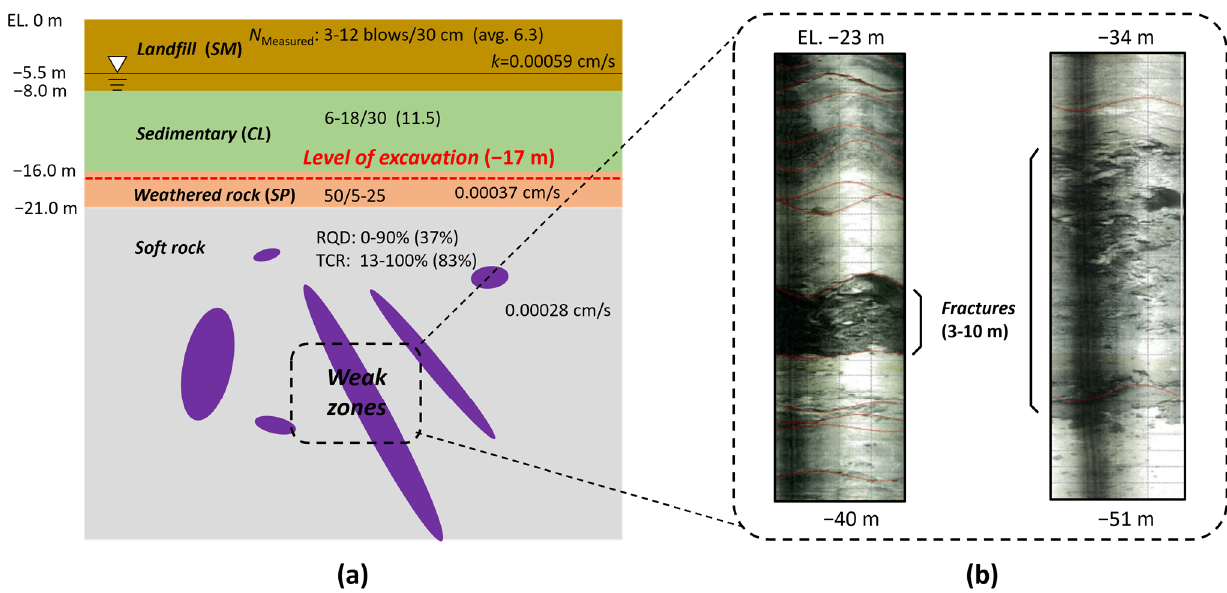
Figure 2. Profiles of the construction site. ( a ) Stratification of the site and ( b ) examples of fractures surveyed by BIPS (Note, N measured : measured N value by SPT, k : hydraulic conductivity of soils, RQD: rock quality designation, TCR: total core recovery, SM : sandy silt, CL : clay with low plasticity, and SP : poorly graded sand).